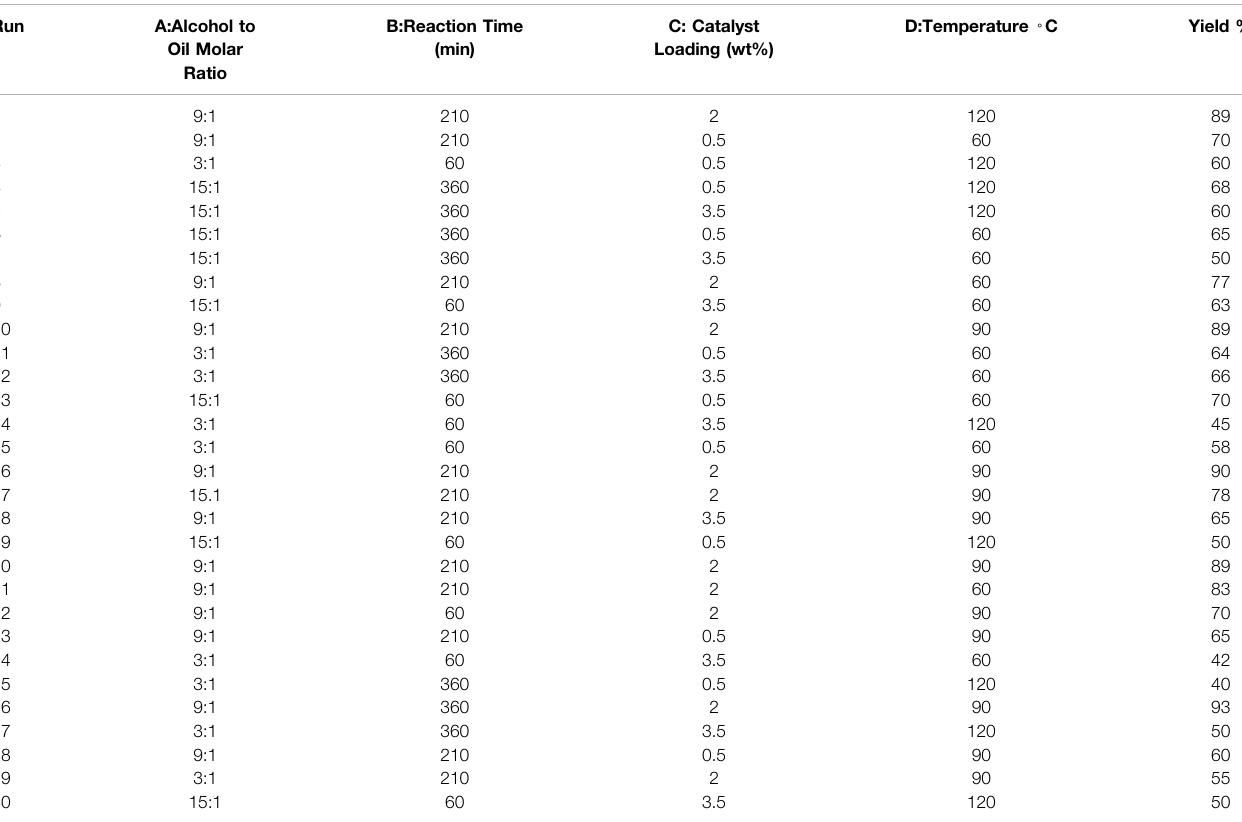
TABLE 1 | Comprehensive experimental results of biodiesel synthesis reaction.